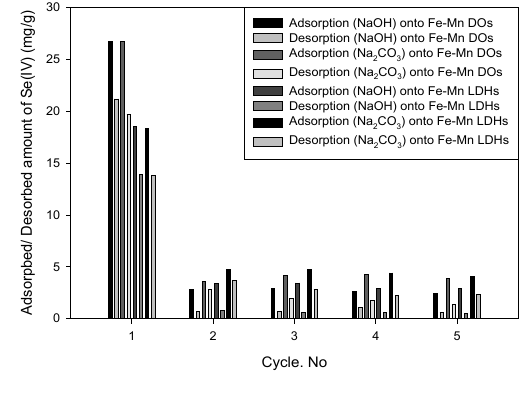
Fig. 8. Adsorption/Desorption